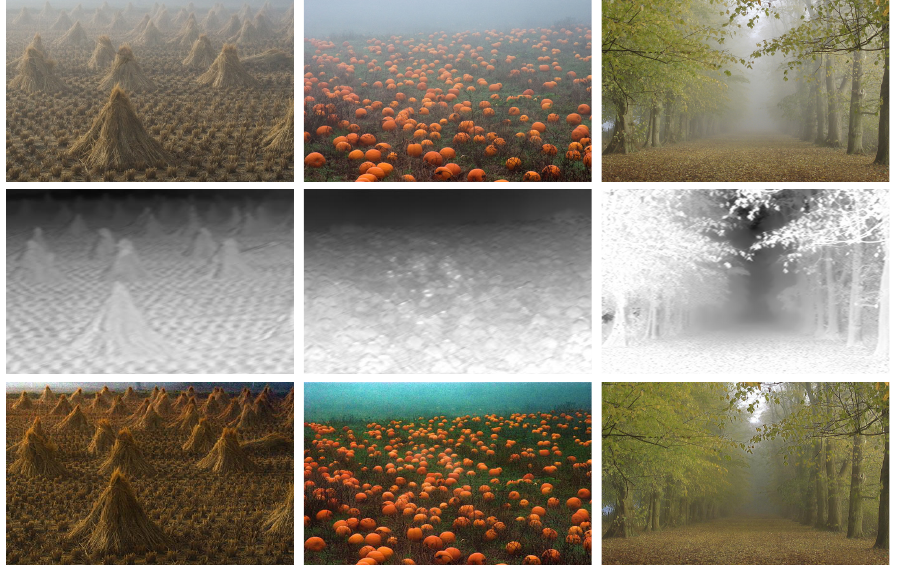
Figure 6. The dehazing results on three typical images: ( Top ) the input haze images; ( Middle ) the recovered transmission maps; ( Bottom ) the dehazed